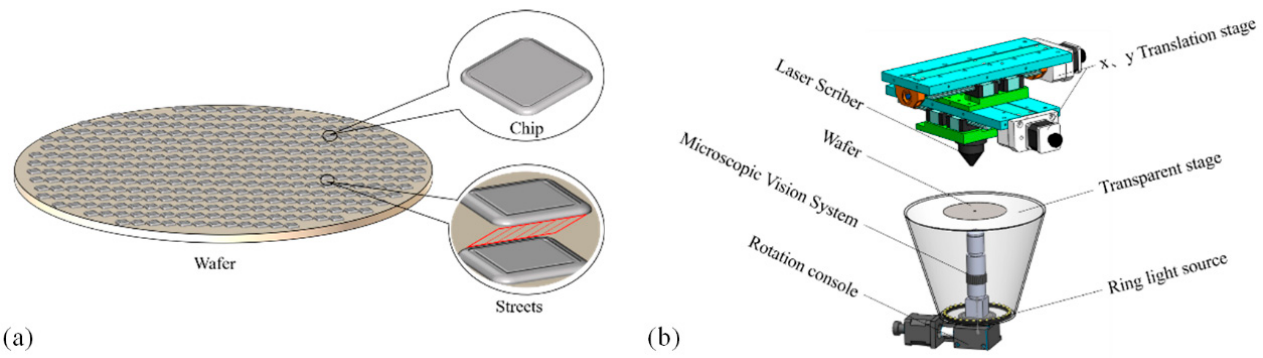
Figure 1. Wafer cutting principle. ( a ) Wafer model; ( b ) the composition of the wafer dicing machine.